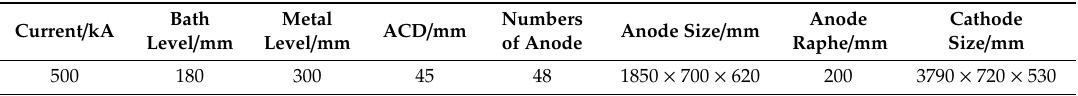
Table 1. Parameters of the aluminum reduction